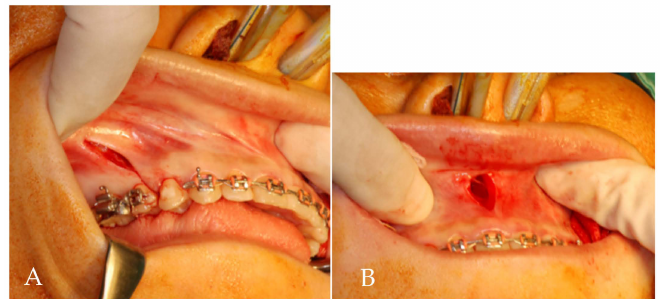
Figure 2. ( A ) Vestibular incision of modified AMSO: a vertical releasing incision from the posterior to distal interdental papilla of the first premolar, extending to the vestibular depth. ( B ) A vertical incision is made through the mucoperiosteum overlying the anterior nasal spine and carried inferiorly 5 mm.